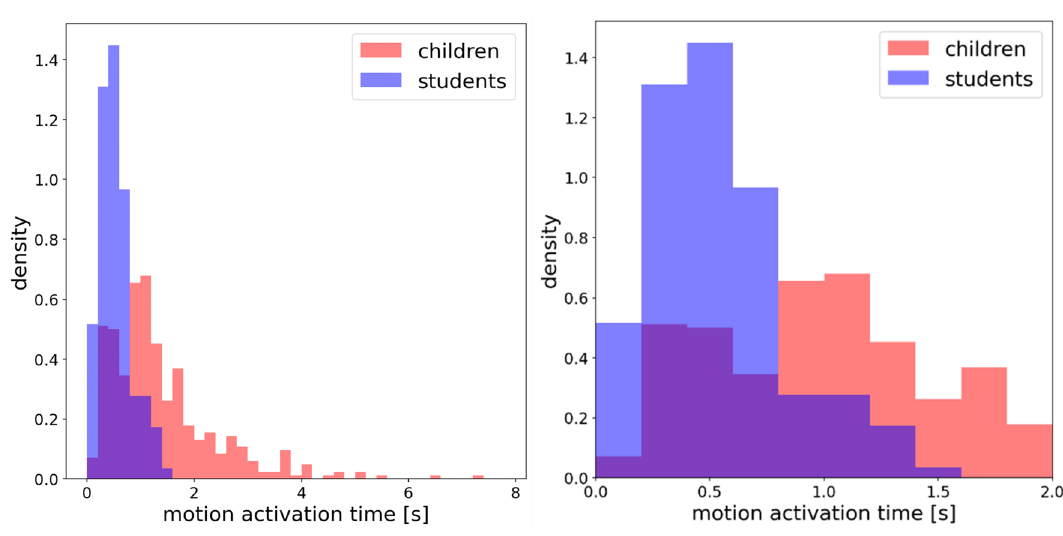
Figure 10. Left: Probability density histogram of motion activation time of children (blue) and adults (red) overall. Right: Detailed histogram of motion activation time in the range of 0–2 s. The bin size is set as 0.2